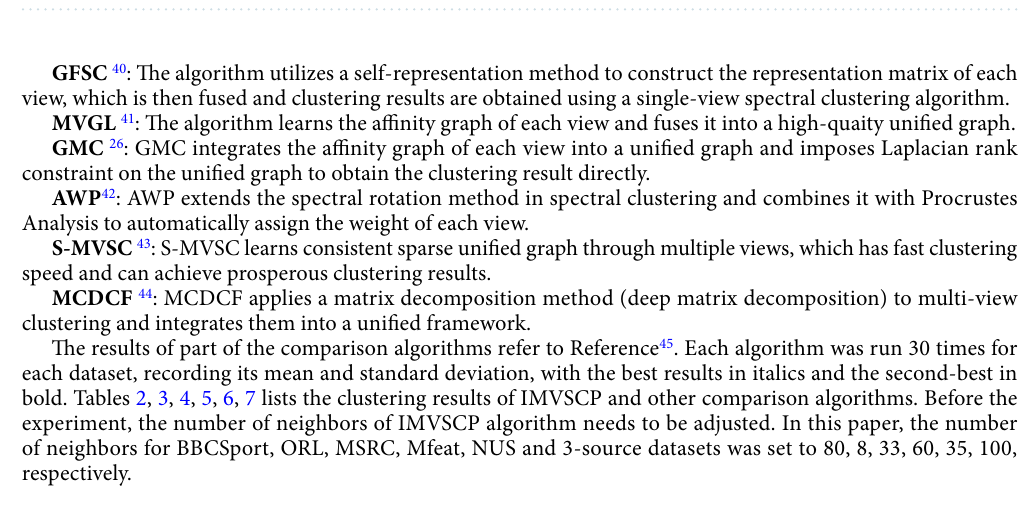
Table 3. Experimental results (mean standard deviation) on the ORL dataset. Significant values are in [bold/